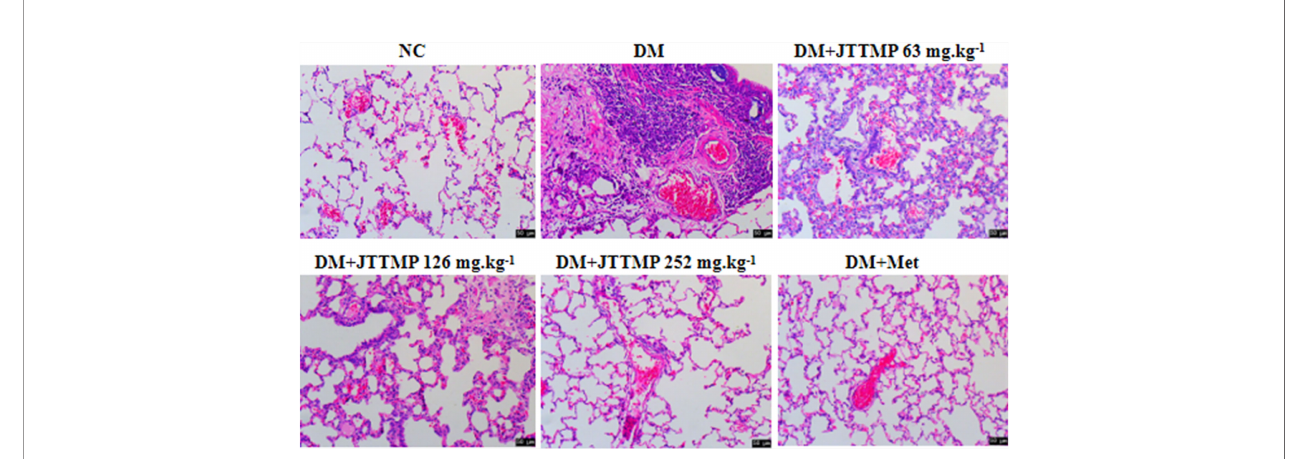
FIGURE 2 | Microphotographs showing structural changes with H&E staining in lung tissue of rats from different groups (200×).